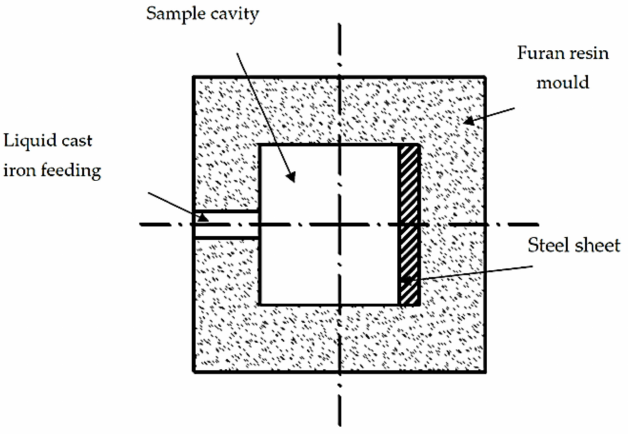
Figure 1. The inserted steel sheet position in mold (transversal